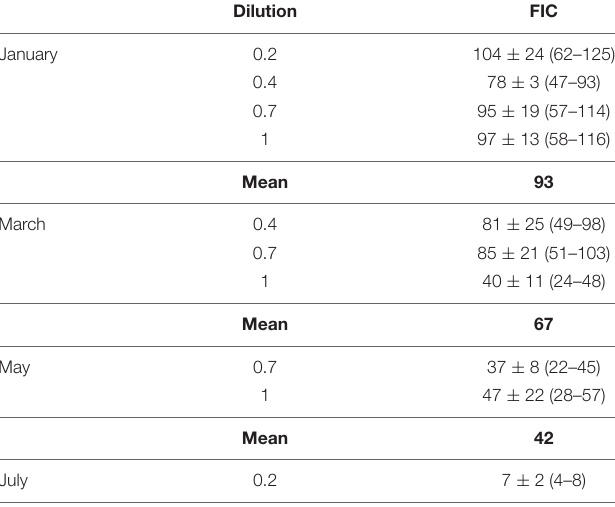
TABLE 2 | FIC of < 0.2- µ m